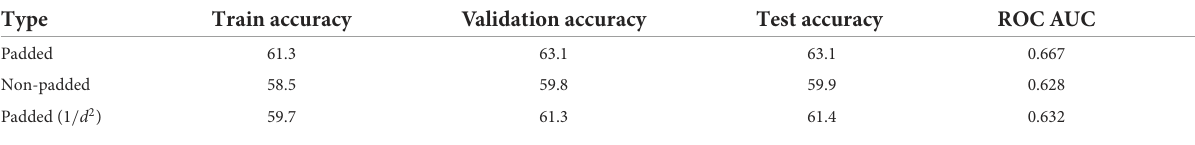
TABLE 1 GCN model applied to padded and non-padded, fully connected, uniformly edge weighted, and inverse square distance (1 / d 2 ) weighted graphs for the simulated IWCD neutron capture and background datasets.